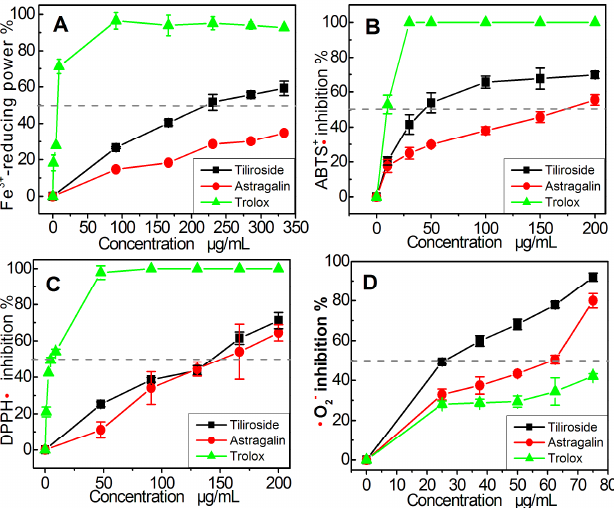
Figure 2. Dose-response curves of astragalin and tiliroside in various antioxidant assays: ( A ) FRAP assay; ( B ) ABTS scavenging assay; ( C ) DPPH•-scavenging assay; ( D ) •O 2– -scavenging assay.